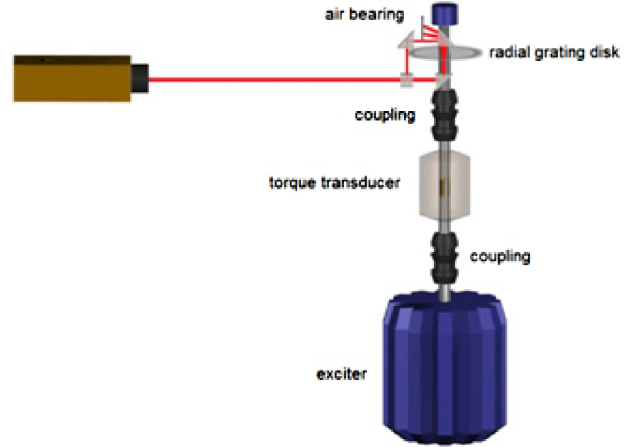
Fig. 17. Model of the dynamic calibration device for torque transducers